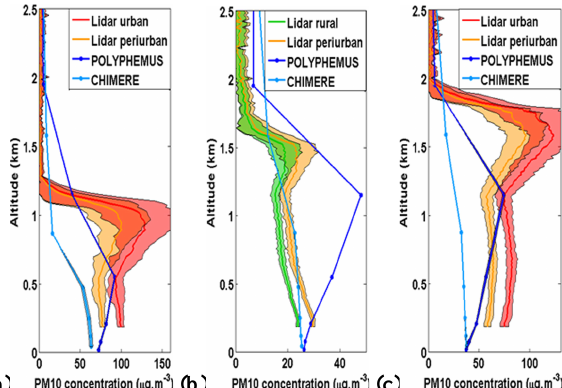
Fig. 4. Vertical profiles of PM 10 concentrations on 1 July at the beginning of the van track near Saclay (a) , at Chateaudun (b) and at the end near Saclay (c) . Data have been averaged over 20 lidar profiles: the mean profile is represented by the solid line and the variability by the shaded area. Lidar measurements below the alti- tude of full overlap are not represented in these